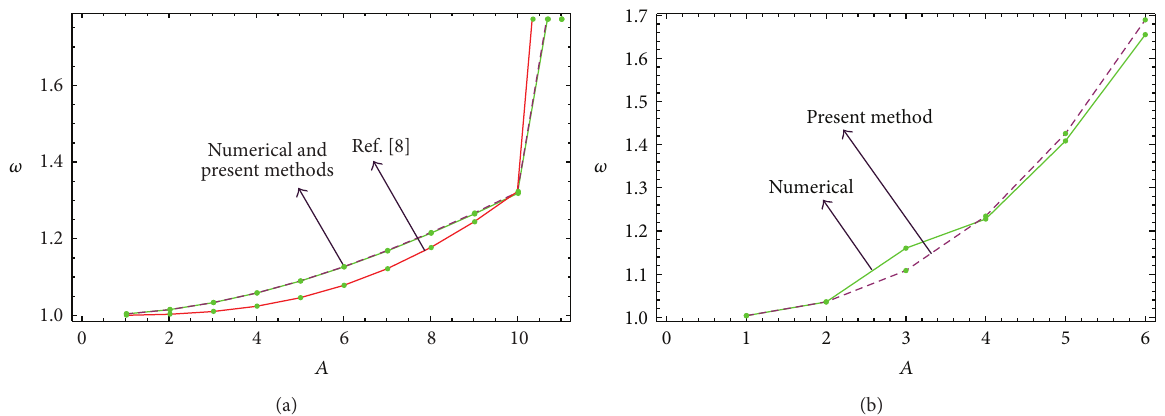
Figure 4: Comparison of the present method with numerical values and [18] for 𝜔 versus 𝐴 of Duffing Oscillator (a) with 𝑛 = 3 , 𝛼 3 = 1 (b) with 𝑛 = 3 , 𝛼 3 = 1 , 𝛼 5 = 1 .